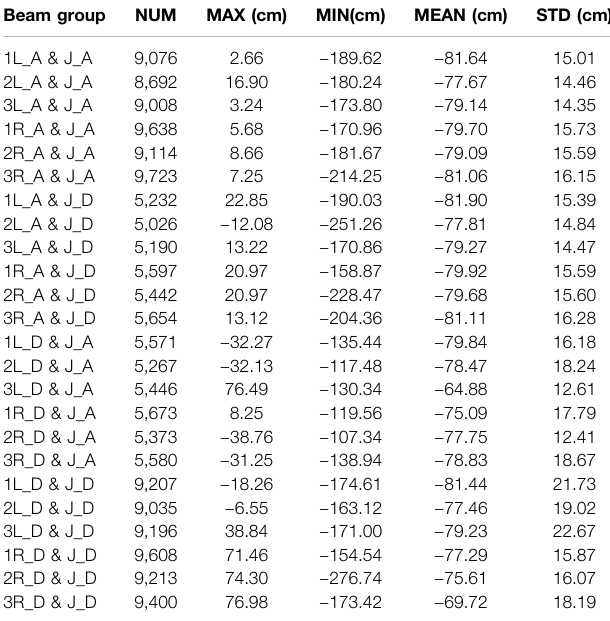
TABLE 1 | Statistical information of crossover differences under intra-mission situations. Time limit Jason-2 Cycle 608 – 644